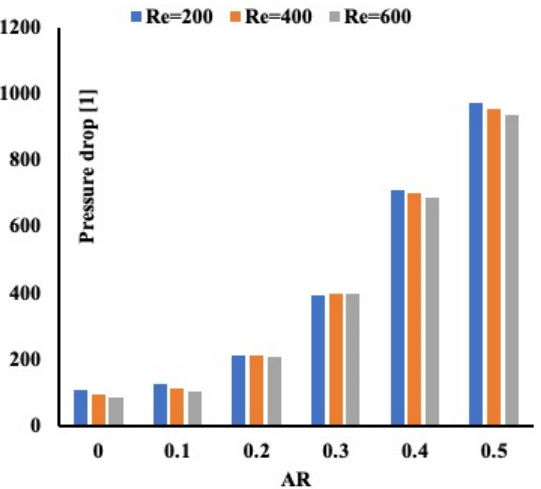
Figure 8. Pressure drop variation as a function of Reynolds number and aspect ratio.